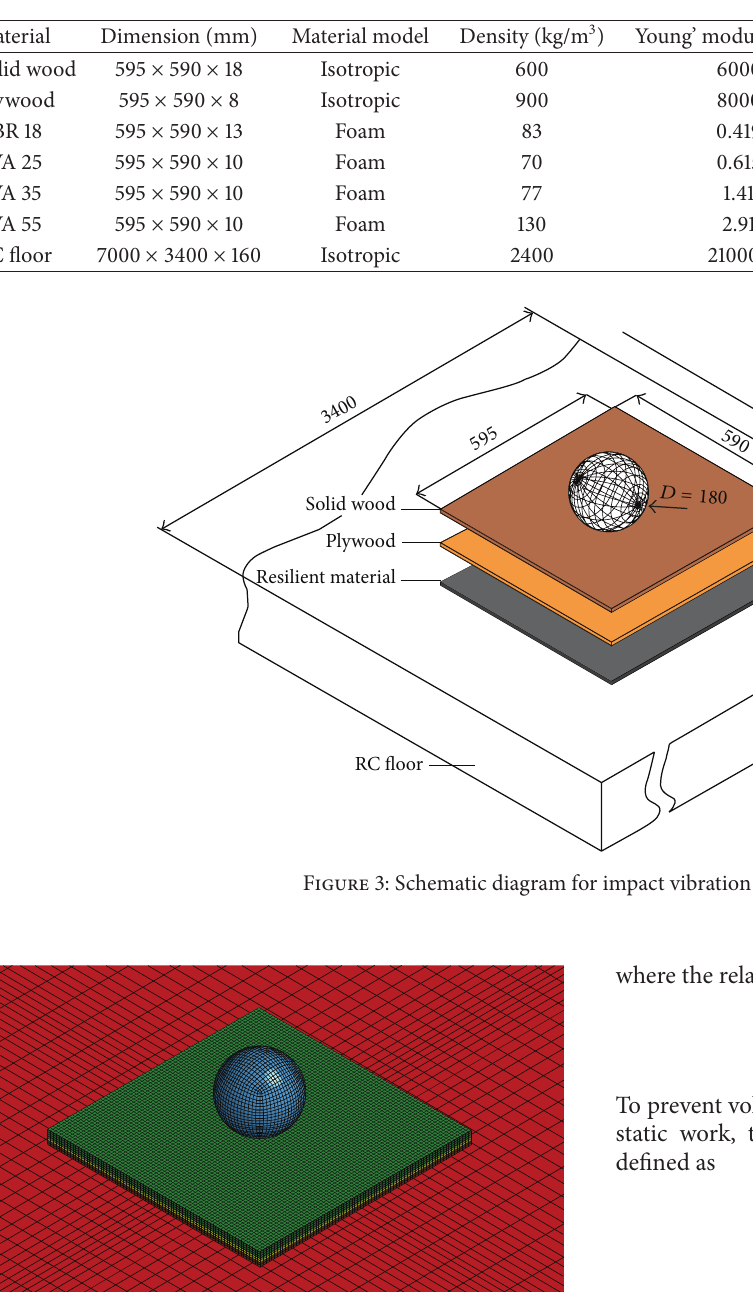
Table 3: Material models and dimensions of the tested panel and RC floor.